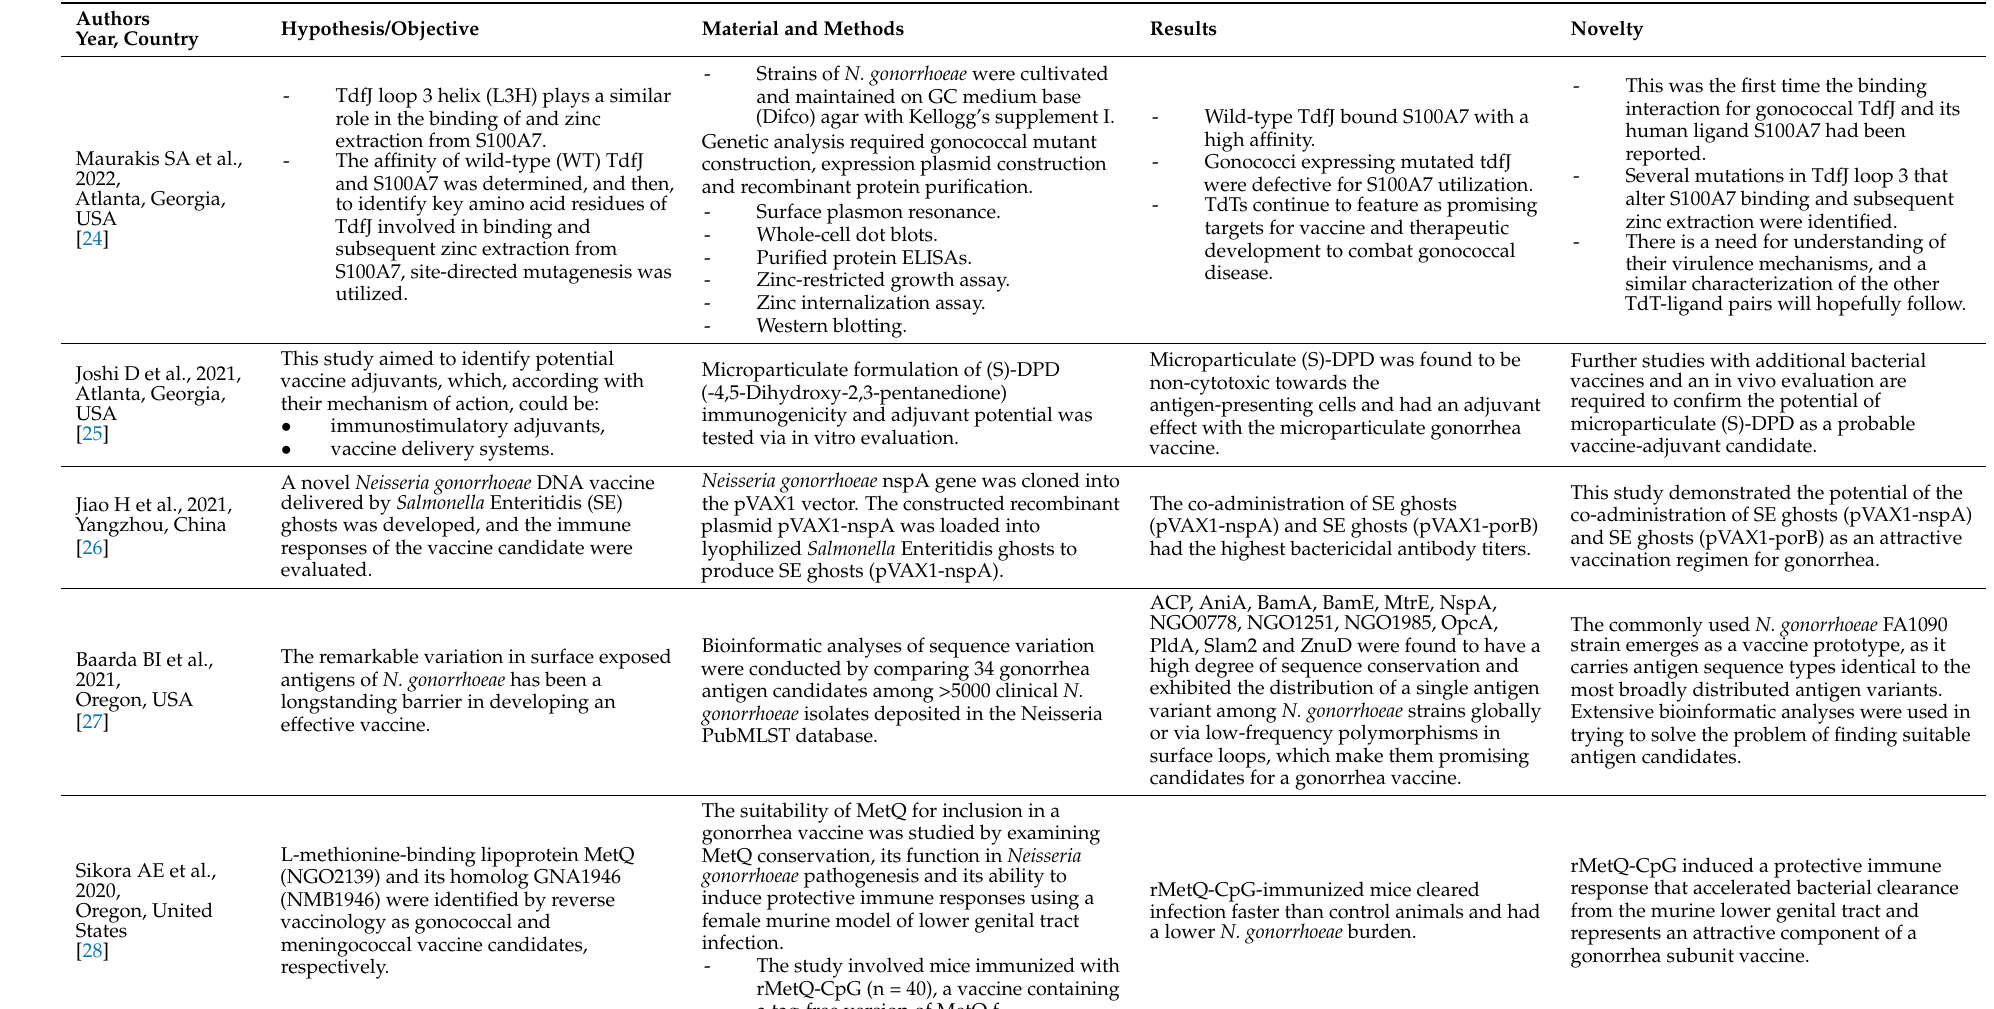
Table 2. Gonococcal vaccine